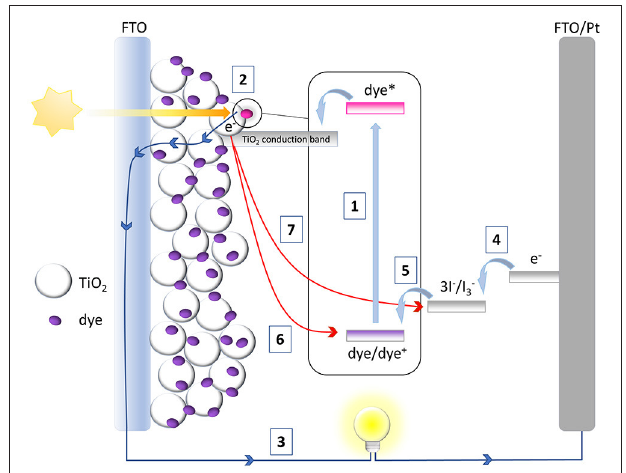
FIGURE 1 | Architecture and operation principles of a typical